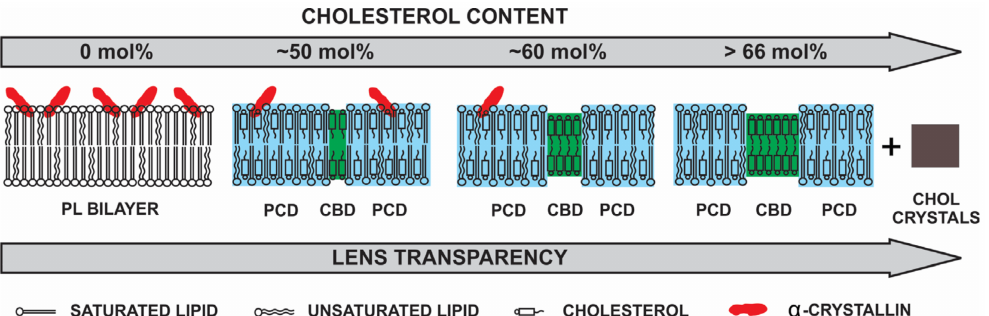
Figure 6. Schematic drawing showing the decreased α -crystallin binding to the lipid membrane with increased Chol content. An increase in Chol content saturates the membrane, forming the phospholipid cholesterol domain (PCD). With a further increase in Chol content, cholesterol bilayer domains (CBDs) coexist with the PCD. CBDs start to form at 50, 48, 46, and 33 mol% Chol within the PC, SM, PS, and PE membranes, respectively [130]. CBDs are shown in green color in the schematics. The CBD’s size increases with an increase in Chol content, and at above 66 mol% Chol, Chol crystals form, presumably outside the bilayer [113]. The current study’s findings [108] suggest that the binding of α -crystallin to the lens lipid membrane decreases with an increase in Chol content, and no α -crystallin binds to the lipid membrane above likely ~60 mol% Chol in the membrane. The real size of the α -crystallin oligomer (red) is much larger than represented in this figure. The decrease in the binding of α -crystallin to the Chol/lipid membranes made with increasing Chol content represents the decrease in light scattering and increase in lens transparency. Adapted from [108], Copyright 2021, with permission from